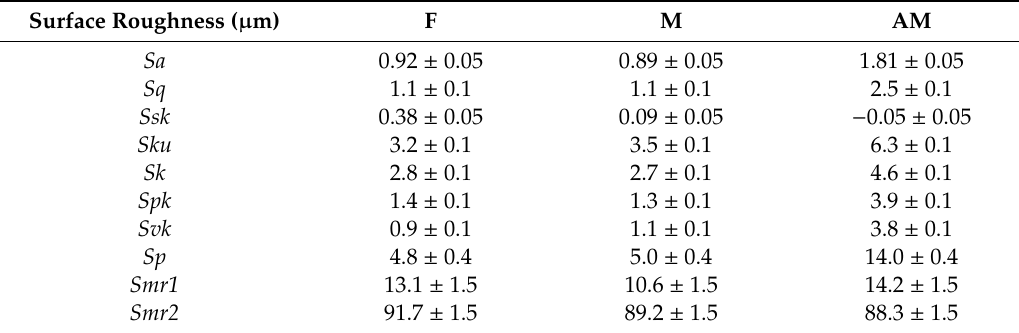
Table 4. Surface roughness of test